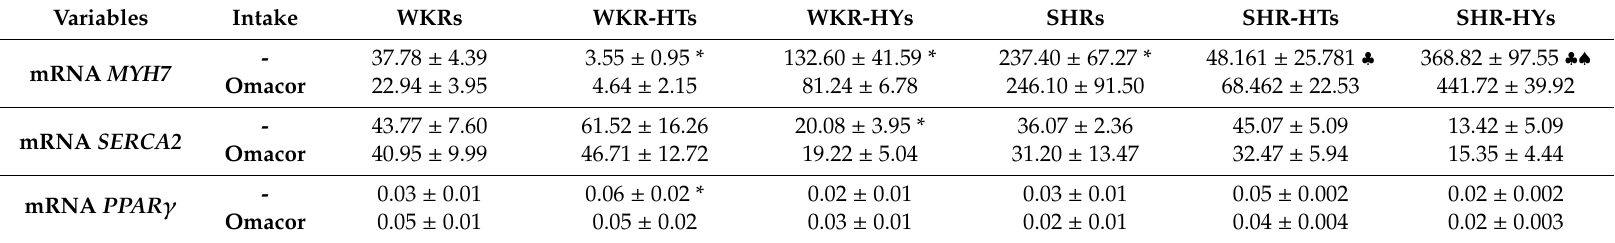
Table 3. Myocardial mRNA transcripts level in the male experimental